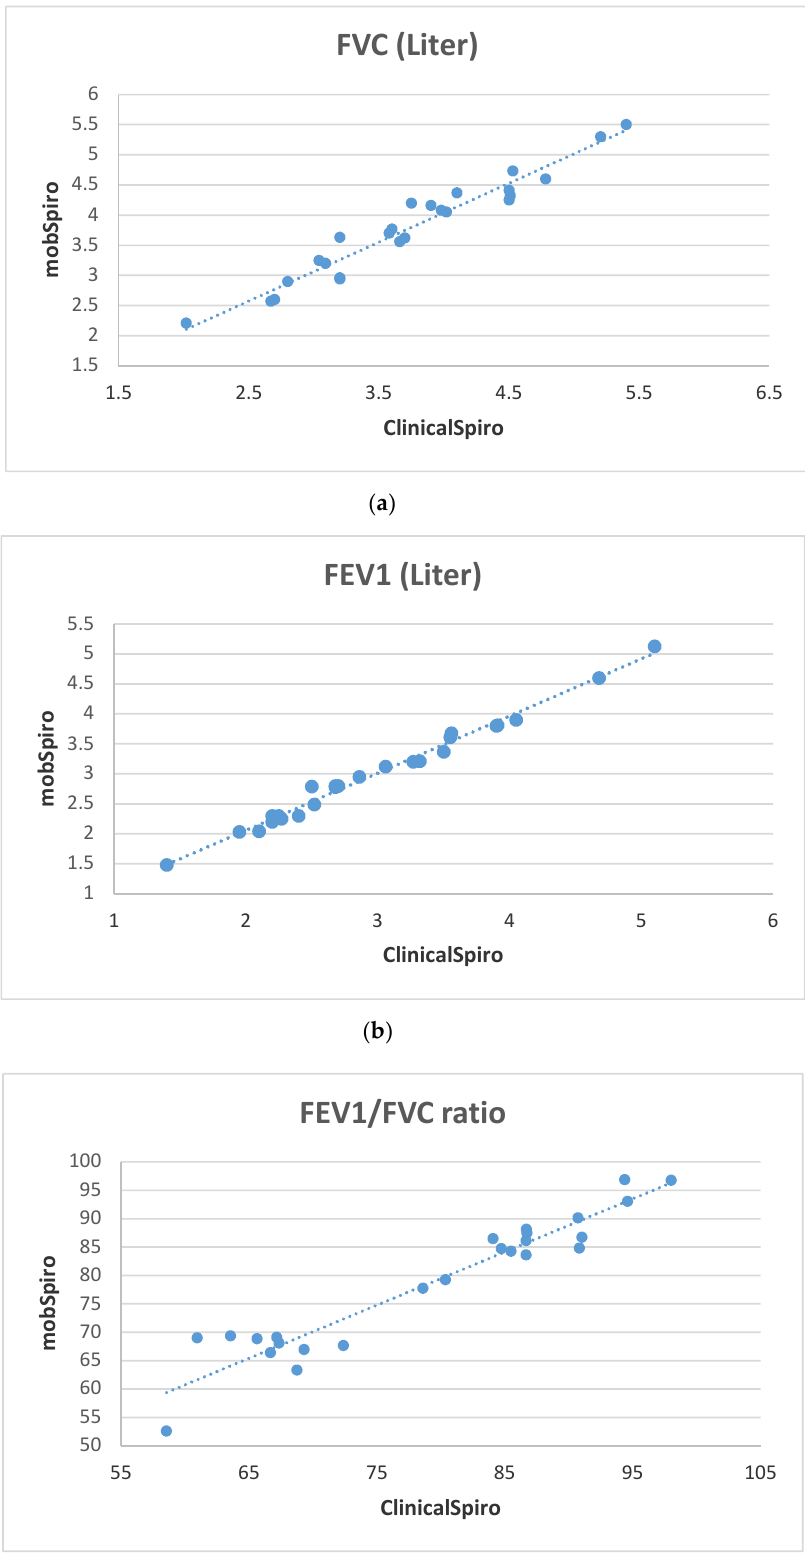
Figure 8. Comparative Graphs. ( a ) FVC differences between mobile and real spirometer results. ( b ) FEV1 differences between mobile and real spirometer results. ( c ) FEV1/FVC ratio differences between mobile and real spirometer results.